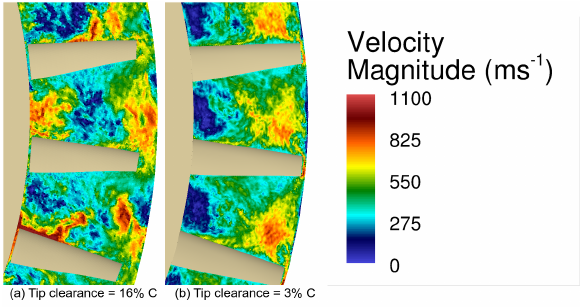
Figure 15. Instantaneous velocity magnitude contours on the plane normal to the axial direction at the location z = 0 passing through the middle of the rotor section at 75% rotor RPM for: ( a ) 16% chord tip clearance; and ( b ) 3% chord tip clearance.